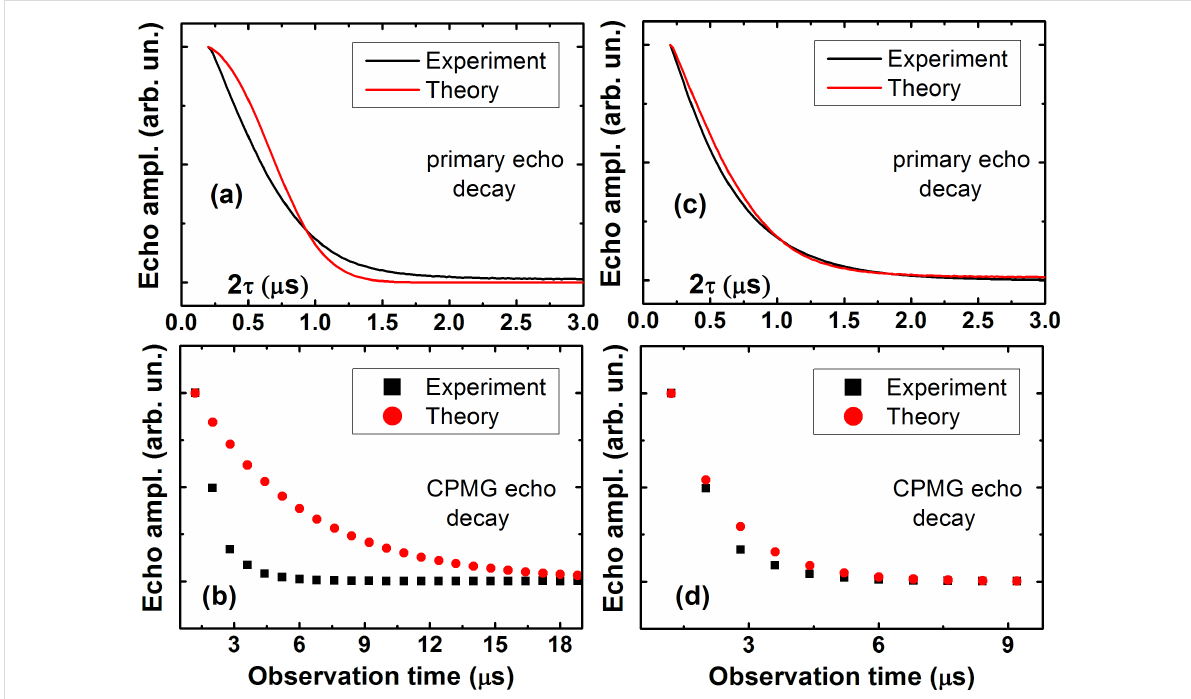
Figure 12: Comparison of the experimental and model dependences of the decay of the primary (a,c) and CPMG echoes (b,d) for complex P1 at T = 80 K. The model curves in (a,b) were calculated according to Equation 7 with the correlation time τ c = 2 µs, the diffusion barrier d = 0.7 nm, and στ c2 ~ 32, and in (c,d) with τ c = 120 ns, d = 0.68 nm, and στ c2 ~ 0.13,